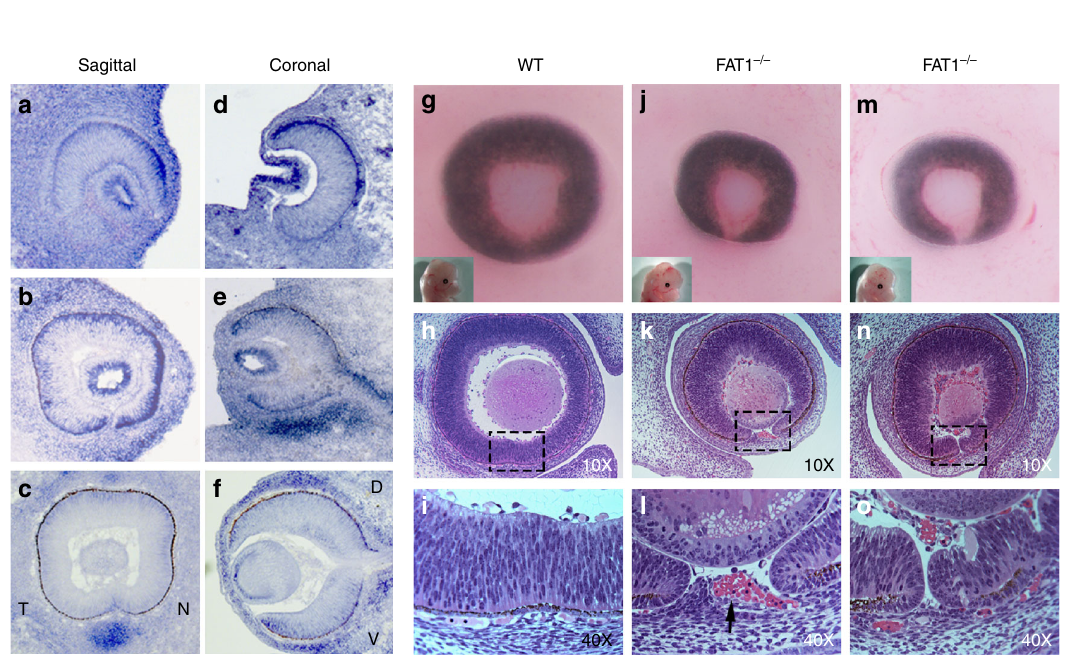
Fig. 2 FAT1 -/- mouse exhibit microphthalmia and completely penetrant coloboma. FAT1 mRNA expression pattern in sagittal ( a – c ) and coronal ( d – f ) mouse optic cup sections at E10.5 ( a , d ), E11.5 ( b , e ), and E12.5 ( c , f ). Compared to wild-type (WT) embryos ( g – i , E14.5) FAT1 − / − mouse exhibited microphthalmia ( j , m ). Fused optic fi ssure margins of WT mouse embryos (E14.5, h , i ; sagittal section) and unfused margins were seen in Fat1 − / − mice ( n , o ) and/or persistence of POM — including early hyaloid vessel precursors ( k , l , arrow) interposing between the closing edges of the fi ssure (E14.5). D dorsal, V ventral, T temporal, N nasal affected individuals. At E14.5, when the optic fi ssure is completely completely penetrant in the homozygous mutant mice and was fused in WT (Fig. 2g – i), Fat1 − / − mice showed unfused margins never observed in heterozygous mutant mice. Occurrence of (Fig. 2n, o) and/or persistence of POM — including early hyaloid unfused optic fi ssure margins apposed to each other and presence vessel precursors (Fig. 2k, l, arrow) interposing between the of POM tissue in the choroid fi ssure obstructing the fusion of closing edges of the fi ssure. Compared to wild-type (WT) optic fi ssure margins, suggests multiple mechanisms like fusion embryos (Fig. 2g) FAT1 − / − mouse exhibited microphthalmia and morphogenetic defects contributing towards the coloboma (Fig. 2j, m). The coloboma phenotype was observed to be phenotype. NATURE COMMUNICATIONS| (2019) 10:1180